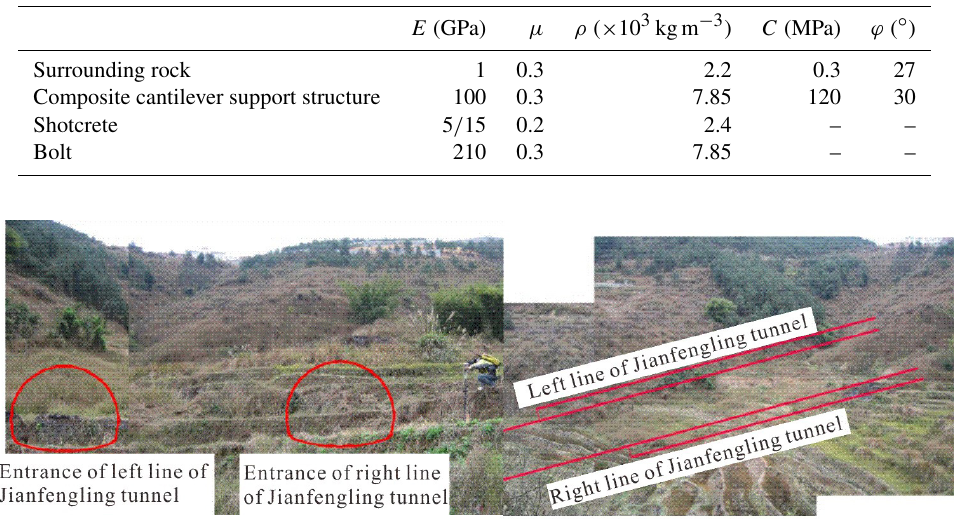
Table 1. Parameters of the numerical model.